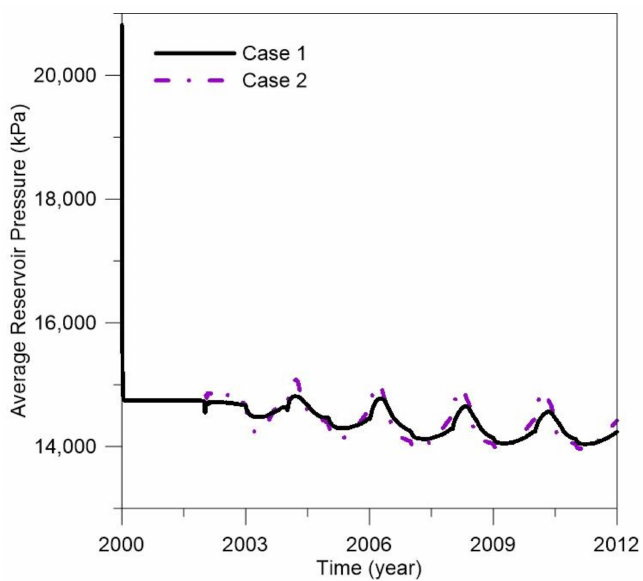
Figure 7. Average reservoir pressure during the CO 2 and impure CO 2 WAG